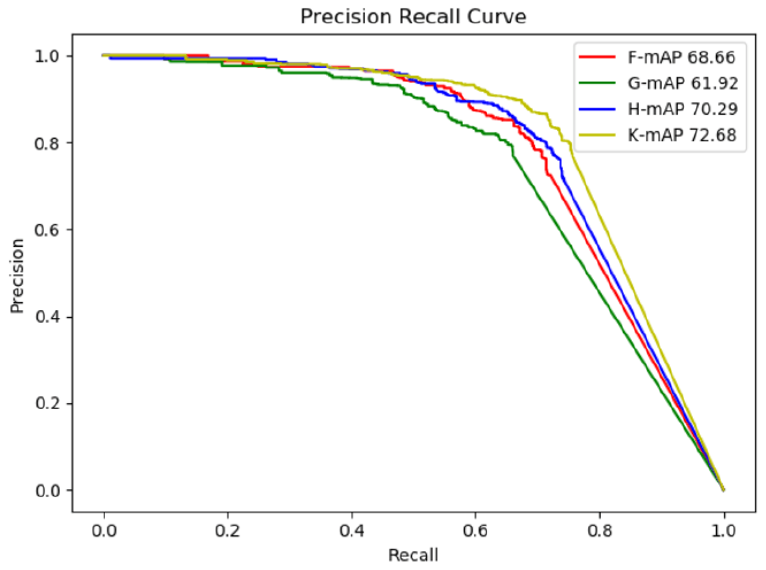
Figure 10. Different detection results with four groups of datasets (two types of materials)